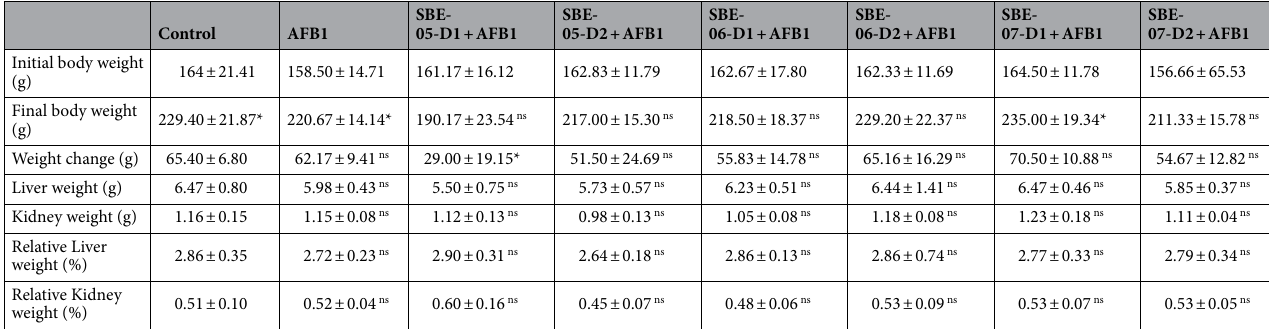
Table 3. Body weight gain and relative Liver and Kidney weight of rats following exposure to AFB1 for 28 days. AFB (50 µg/kg); SBE-05-D1, SBE-05-D2, SBE-06-D1, SBE-06-D2, SBE-07-D1 and SBE-07-D2 (10 and 20 mg/Kg respectively) body weight; n = 6. Data are expressed as mean ± SD. ns : p > 0.05 versus Control; ns : p > 0.05 versus AFB1 alone (using ANOVA); *: p < 0.05 versus FBW; ns : p < 0.05 versus FBW (using paired